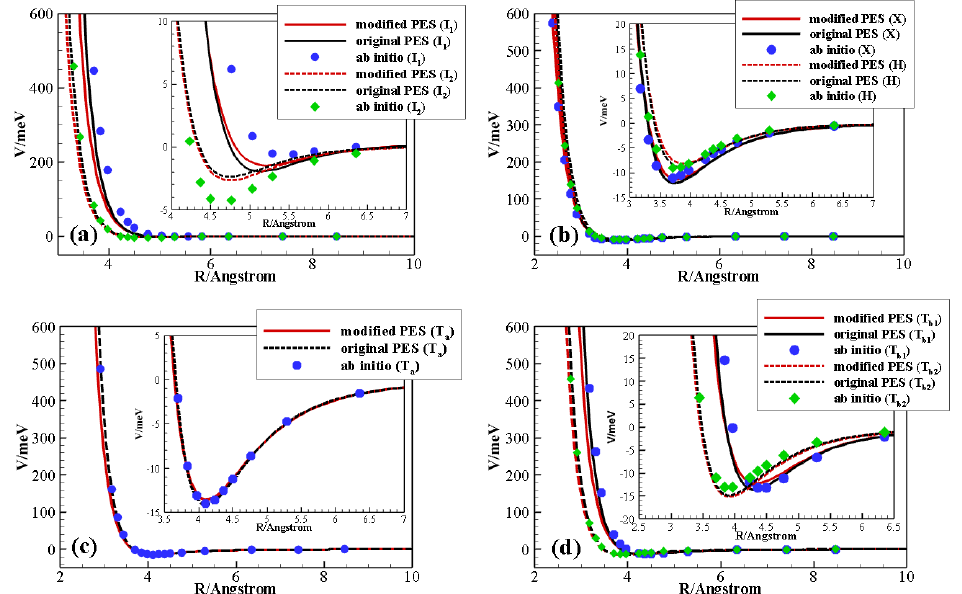
Figure 4. Behavior of different potential energy surfaces as a function of the diatomic interaction distance. Selected configurations, at the equilibrium intramolecular diatomic distance of both monomers, are considered: I 1 and I 2 (panel a ), X and H (panel b ), T a 1 (panel c ), and T b 1 and T b 2 (panel d